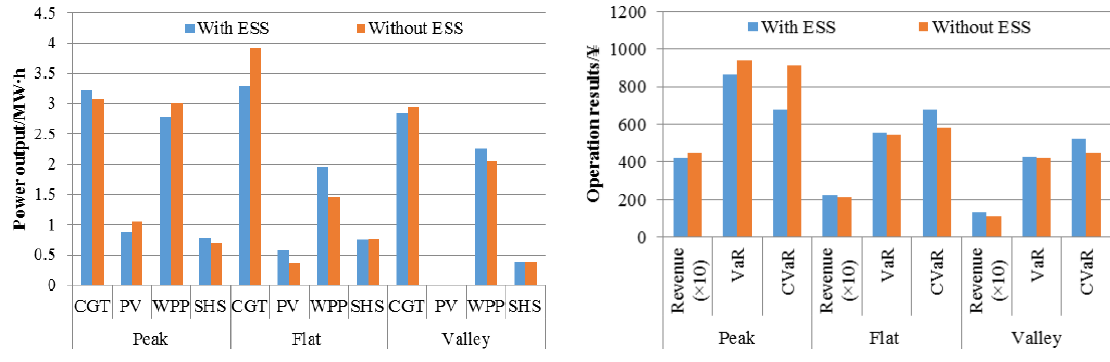
Figure 12. Operation results of VPP with/without ESS. Table 5. Scheduling results of VPP operation under different ESS Capacities (typical winter